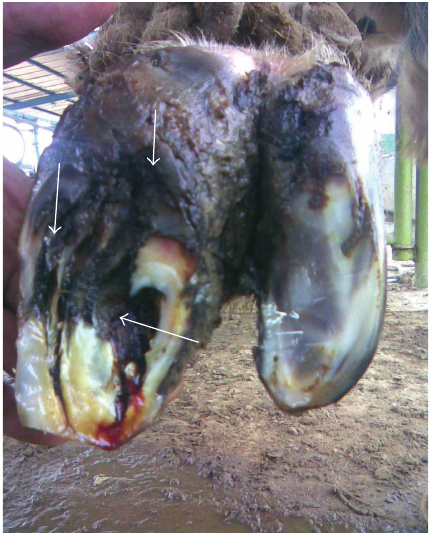
Figure 6: Heel erosion, white line fissure, and underrun sole.